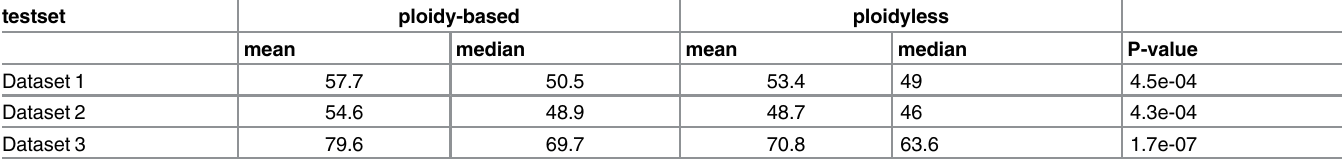
Table 3. Weights generated by the ploidy-based and ploidyless method. P-values were generated using a two-sided paired Wilcoxon test.